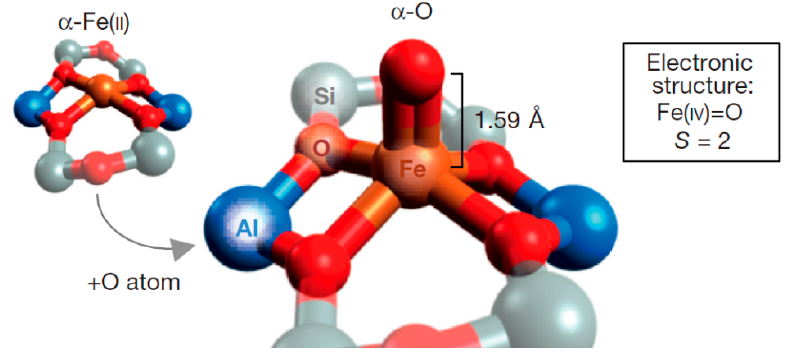
Figure 5. DFT ‐ optimized structure of α‐ Fe (iv) = O sites in the S = 2 ground state. Adapted with Figure 5. DFT-optimized structure of α -Fe (iv) = O sites in the S = 2 ground state. Adapted with permission from [46]. Copyright 2016 Nature. permission from [46]. Copyright 2016